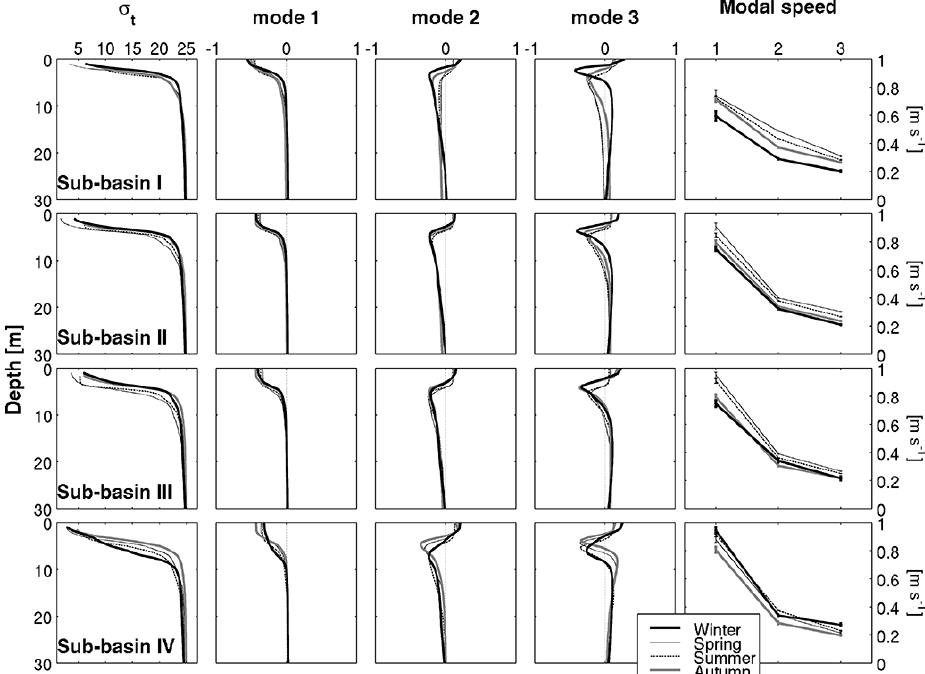
Figure 5. The left panel shows mean density ( σ t ) within the sub-basins. The panels to the right of these show the first three baroclinic ψ n (z) modes and modal speeds obtained from the CSM analysis (normalized). Note that phase velocity is in ms − 1 .